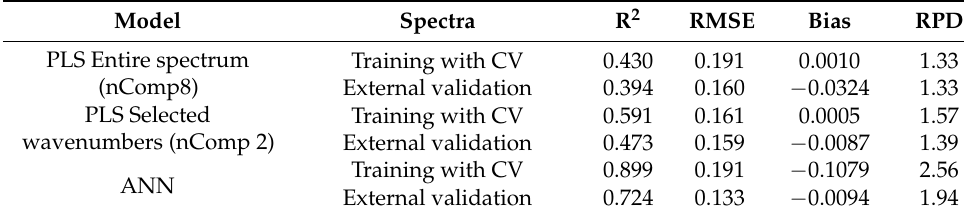
Table 2. Best performing models’ parameters for BS.